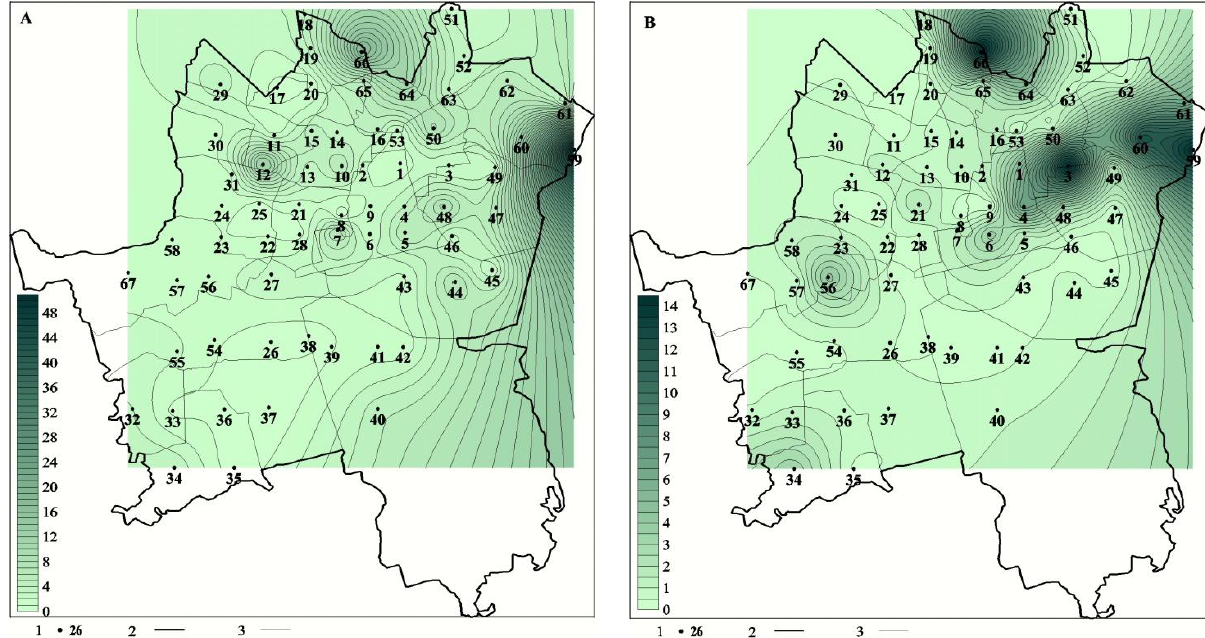
Fig. 4 A, B. Distribution of cadmium: A. in soil [mg kg -1 ] and B. in T. officinale Web. leaves [µg g -1 ] within the city of Katowice. 1 – collection points; 2 -the city boundaries; 3 – boundaries of